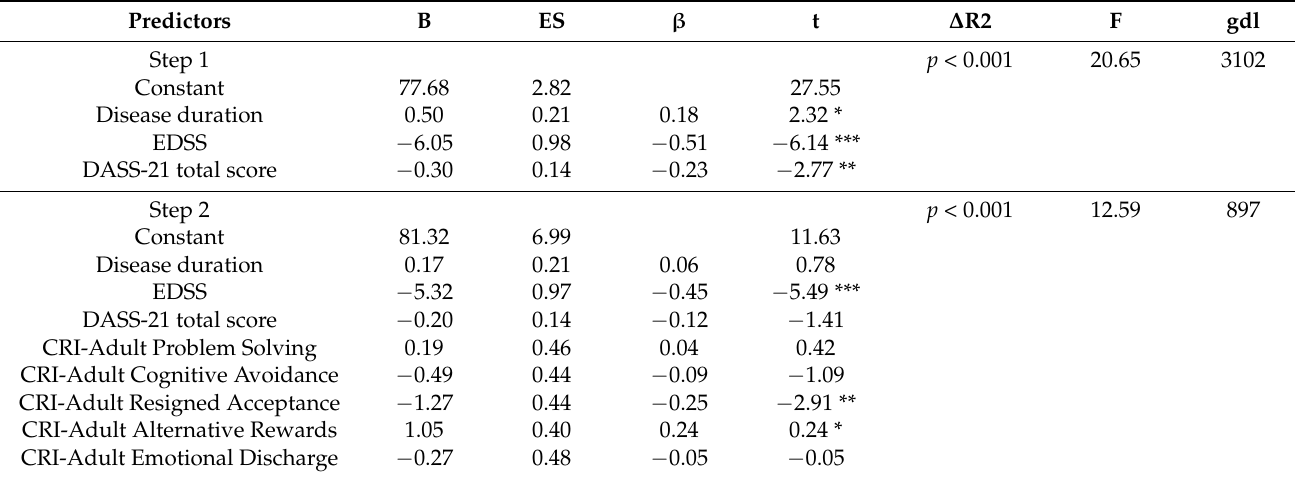
Table 2. Results of the multiple regression analysis predicting MSQoL-29 physical health composite score.